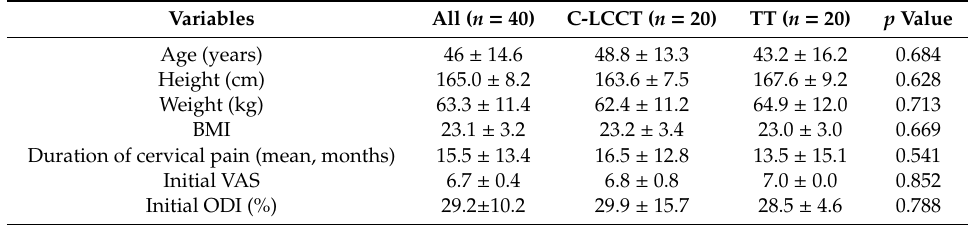
Table 1. Demographic characteristics of participants.